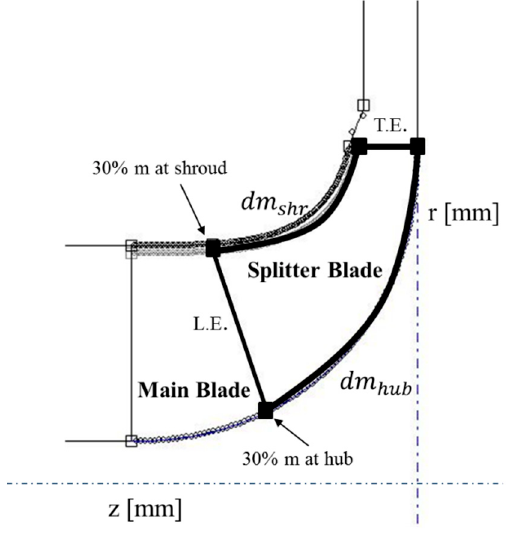
Figure 4. Meridional position of the leading edge of the splitter blade for the base centrifugal compressor.